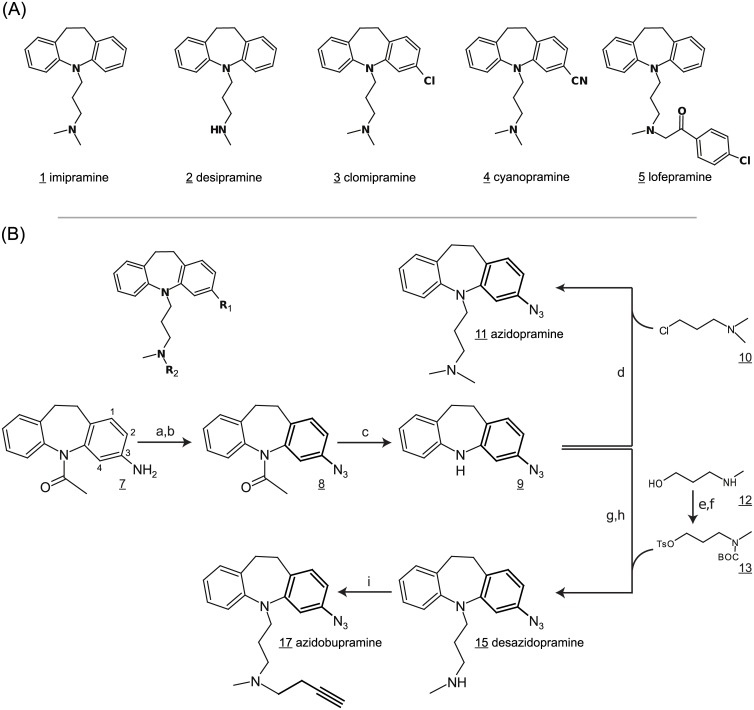
Synthesis scheme of multifunctional antidepressants and reference compounds.(A) Reference substances: overview of clinically active antidepressants (1, 2, 3, 4, 5); (B) Synthesis scheme of azidobupramine: a) NaN3, H2O, RT, 1h. b) NaNO2, 10% HCl c) KOH, MeOH, 60°C, 15h. d) NaH, ClCH2CH2CH2N(CH3)2 (10), 0–60°C, toluene. e) (Boc)2O, DMAP, ACN, RT, 2h. f) TsCl, Et3N, DCM, 0°C. g) NaHMDS, toluene, -78°C to 70°C, 6h. h) 20% TFA, DCM, RT, 4h. i) 1-bromo-3-butyne, K2CO3, KI, 60°C, 12h, acetone.